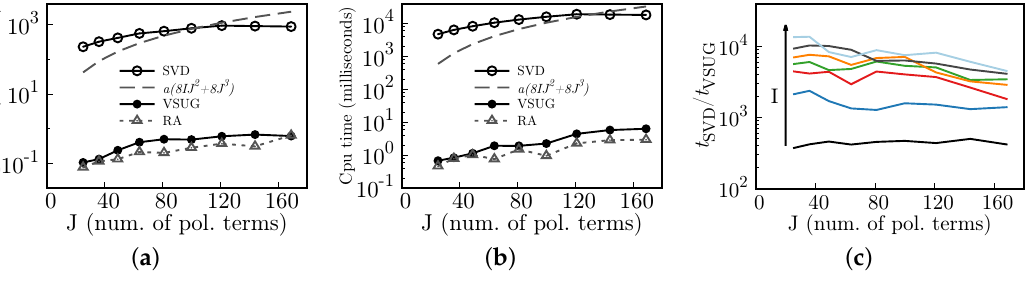
Figure 8. Processing times (CPU times) for different grid sizes ( I ), number of polynomial terms ( J ), and matrix operations. SVD is Singular Value Decomposition, VSUG represents the product VS − 1 U T G (Equation (10)), and RA the product RA (Equation (11)). ( a ) matrix operations for a system with I = 648; ( b ) matrix operations for a system with I = 2724; ( c ) the ratio between SVD and VSGU CPU times, t SVD / t VSGU ; the arrow indicates increasing I , and I takes the values I = 276, 648, 1184, 1876, 2724, 3720, and 4872. In ( a , c ), a ( 8 IJ 2 + 8 J 3 ) is the theoretical flops times a scaling constant a